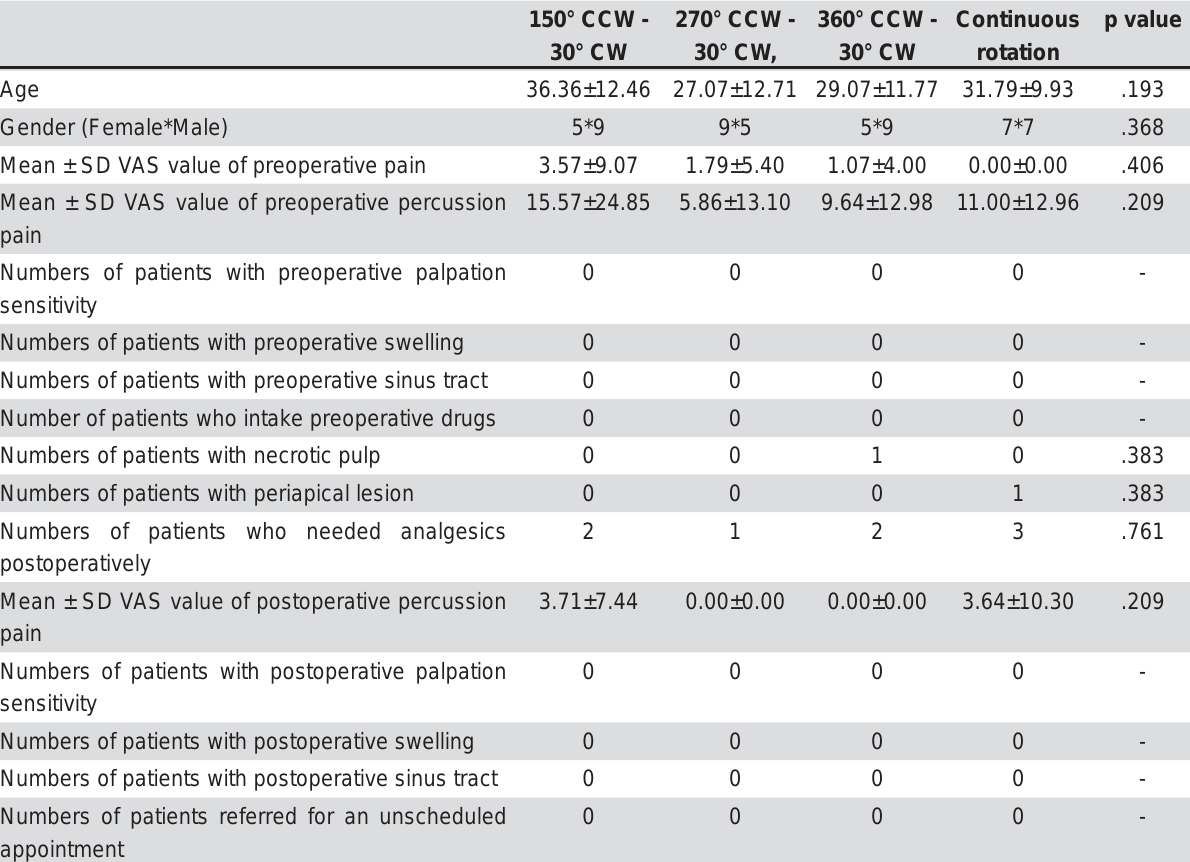
The effect of various kinematics on postoperative pain after instrumentation: a prospective, randomized clinical Table 1- Demographic data (One-way Anova and chi-square were used to analyze the data) (SD: standard deviation)